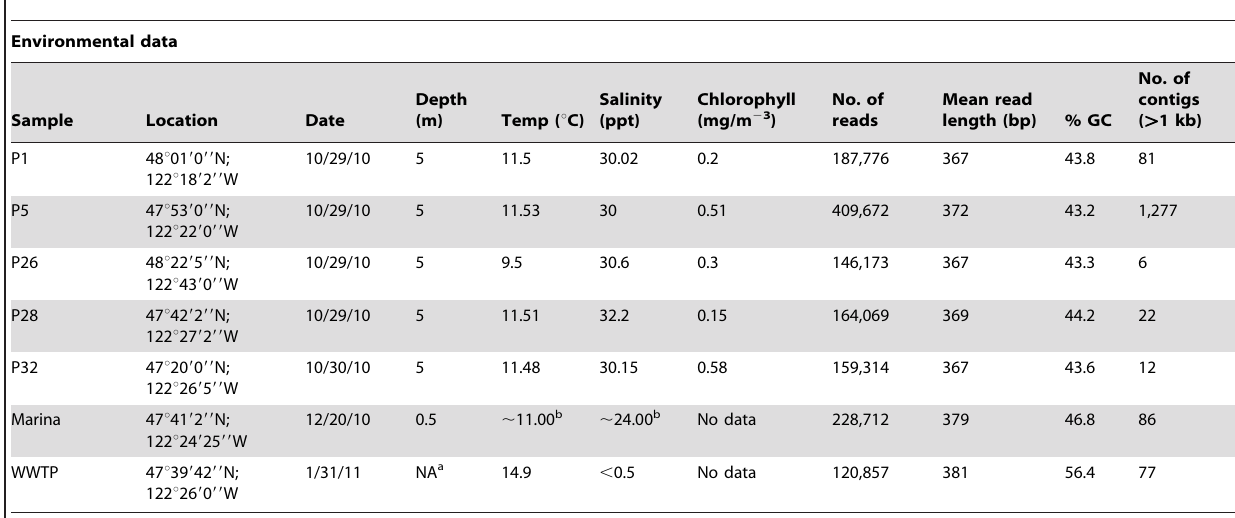
Table 1. Sampling locations and summary statistics for the Puget Sound metagenomes.